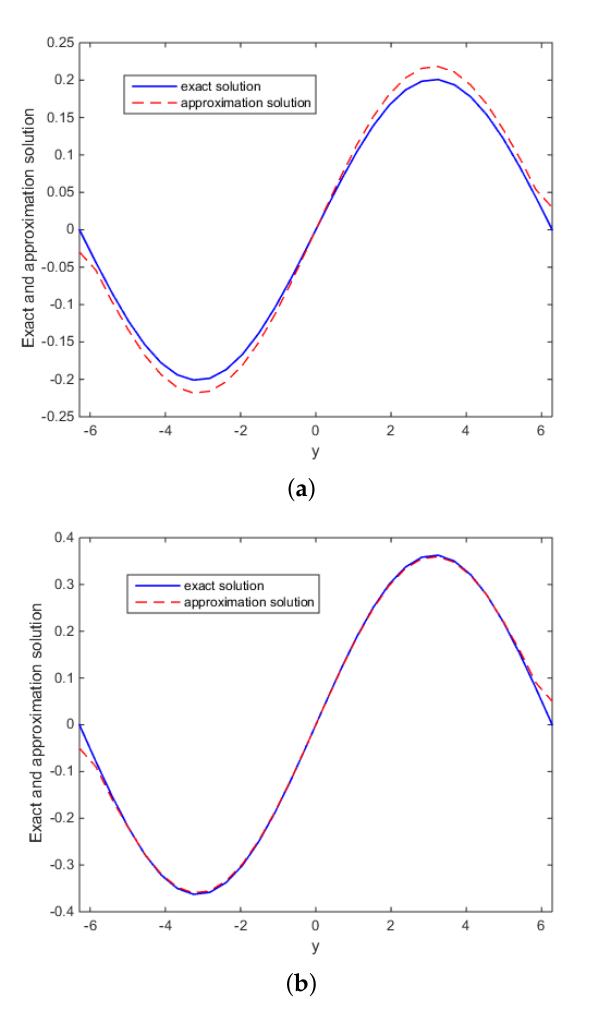
Figure 1. Example 1: The comparison of numerical effects between the exact solution and the approximate solution: ( a ) For the case k = 0.8, δ = 1 × 10 − 6 ; ( b ) For the case k = 10, δ = 1 × 10 − 3 .